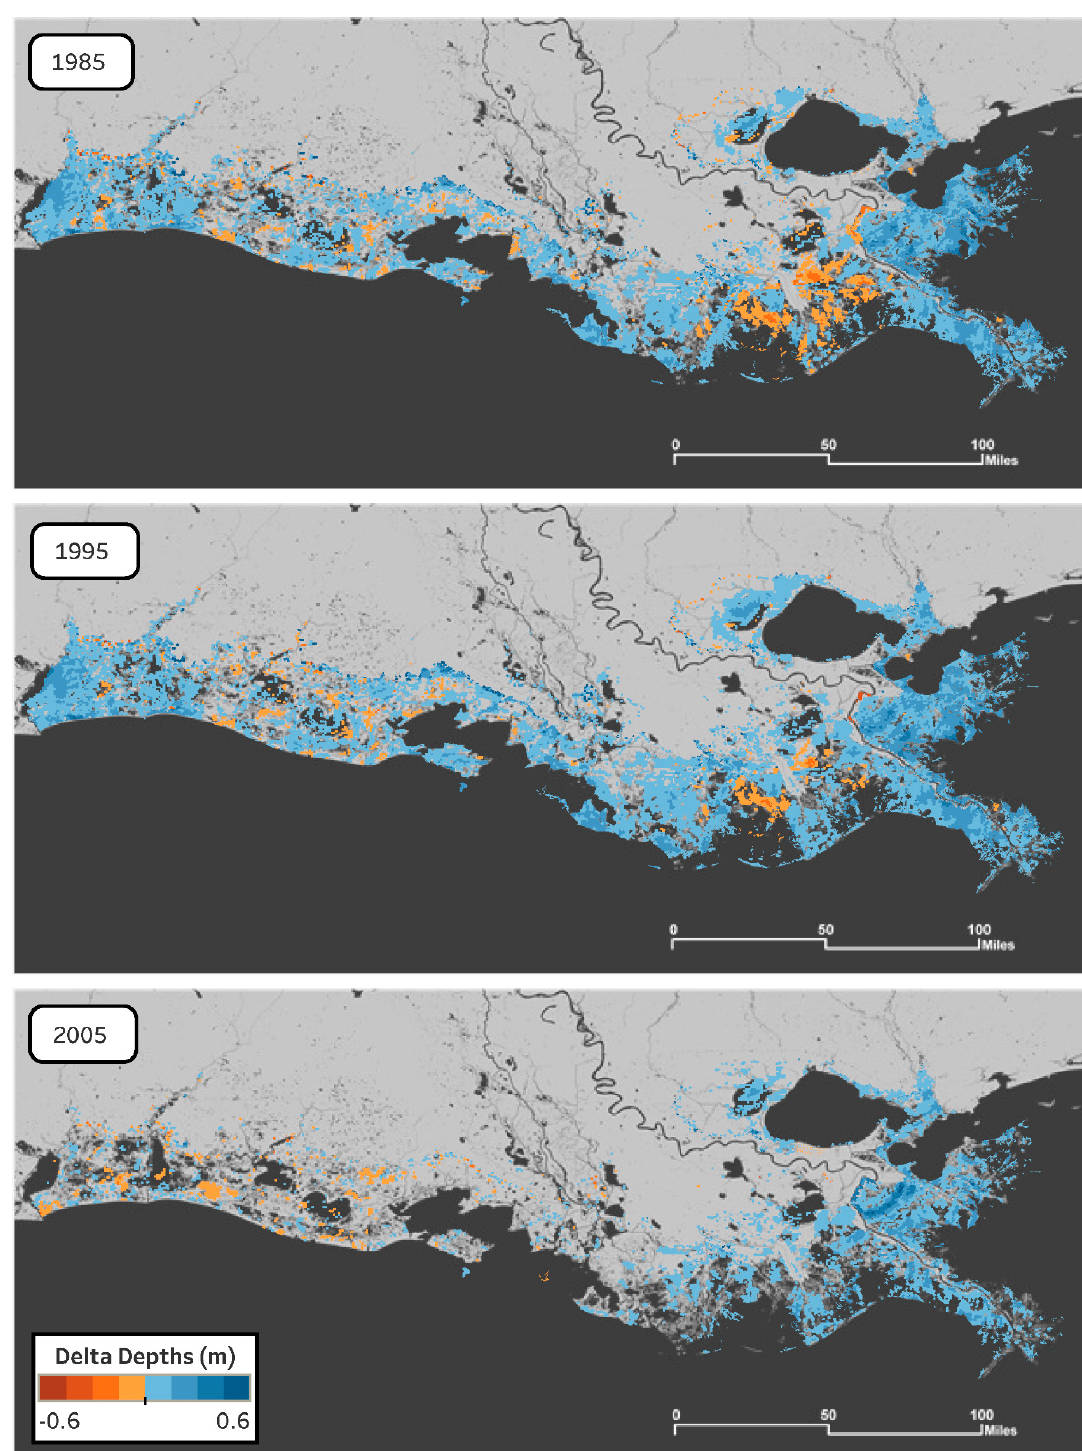
ff erence in 100-year flood depth estimates (reference minus truncated time Figure 3. Difference in 100-year flood depth estimates (reference minus truncated time series). Figure 3. Di